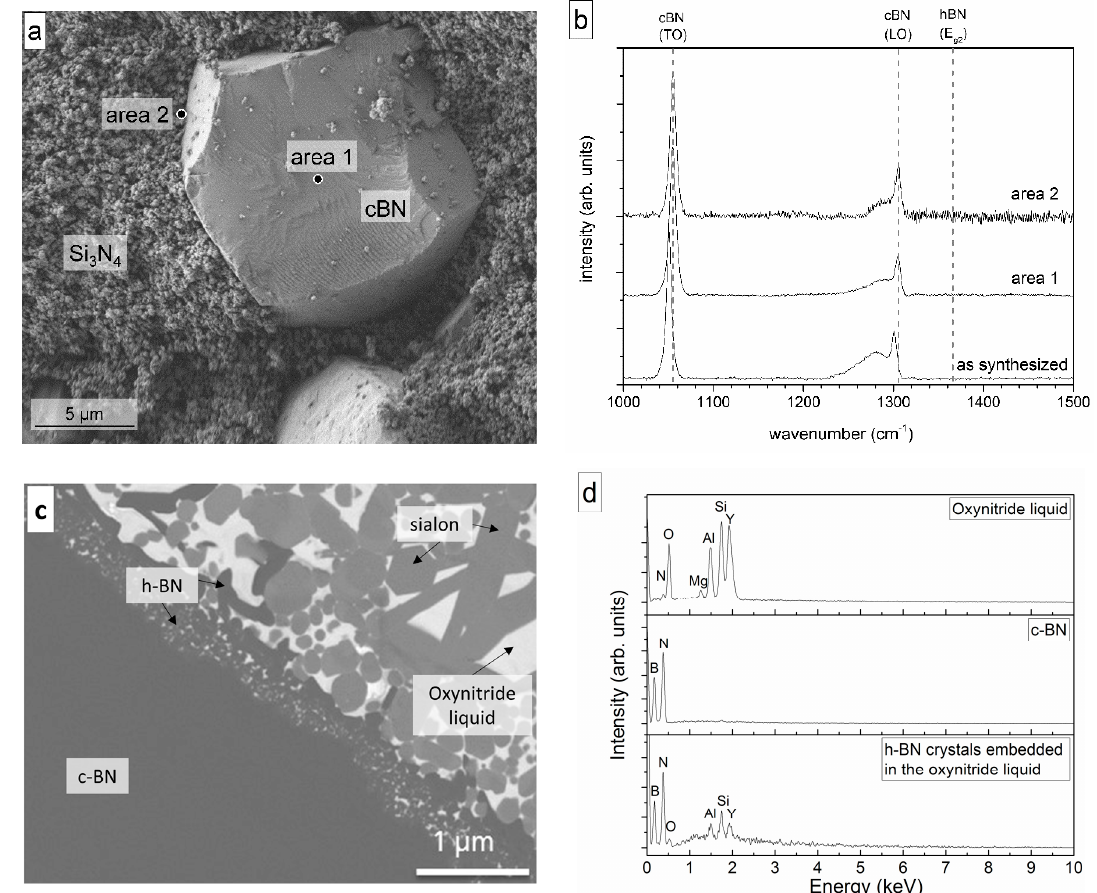
Figure 3. ( a ) SEM micrograph of the fracture surface of the in the spark plasma sintering (SPS) at 1575 °C sintered Si 3 N 4 –c-BN composite without sintering additives and ( b ) Raman spectra of the as-synthesized c-BN powder and one c-BN grain on the fracture surface of the Si 3 N 4 –c-BN composite; ( c ) Interface between c-BN and sialon matrix-densified at 1575 °C. At the interface, the hexagonal boron nitride (h-BN) grains embedded in the amorphous oxynitride grain boundary phase are clearly visible (light gray phase-sialon, bright phase-oxynitride liquid; dark gray-c-BN/h-BN) and ( d ) typical EDX data of these phases.